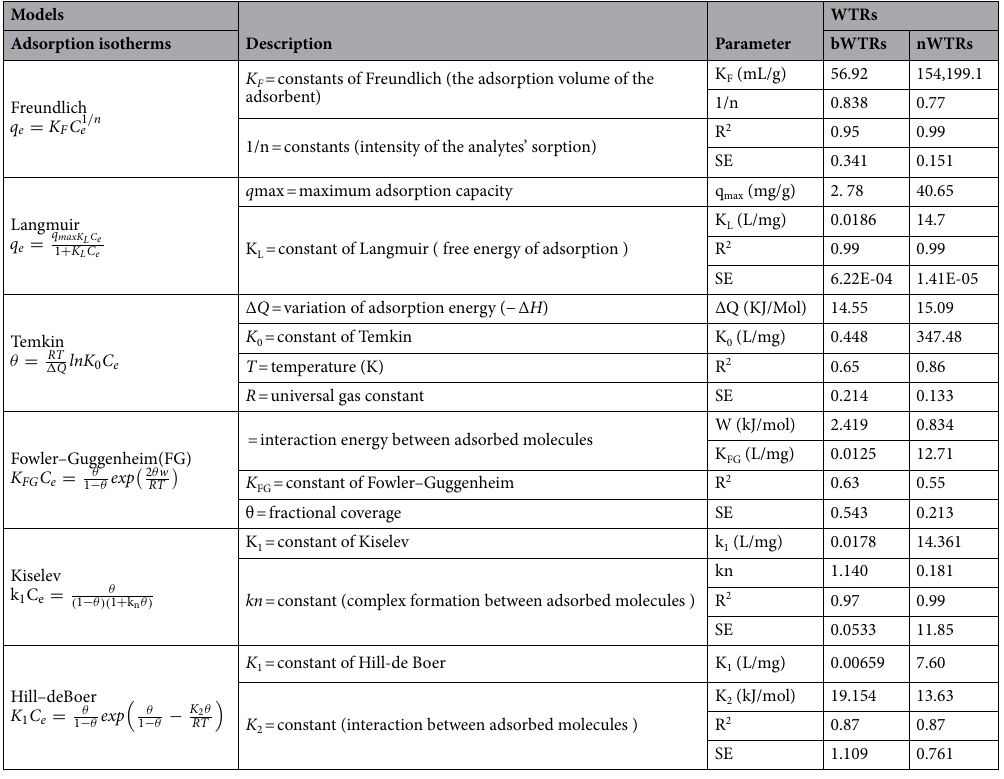
Table 1. The parameters of isotherms models for Cr(VI) adsorption onto the two particle sizes of